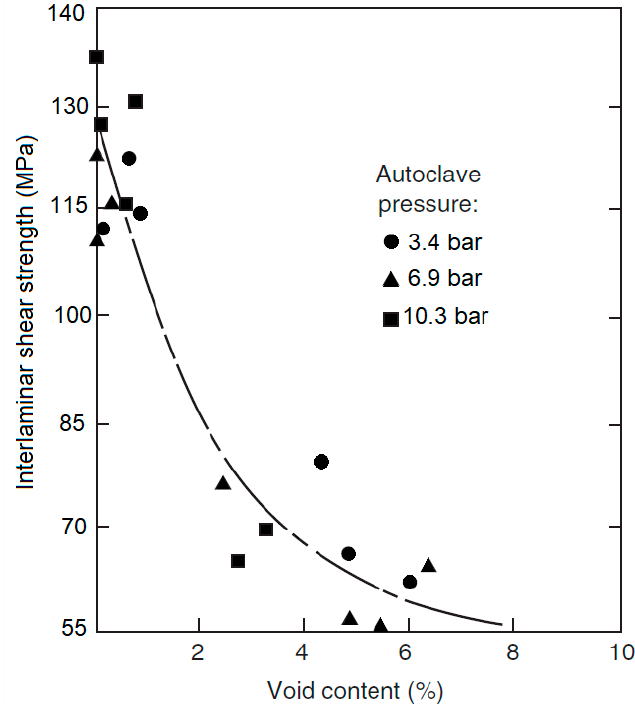
Figure 1. Effect of void content on the interlaminar shear strength, according to [9].